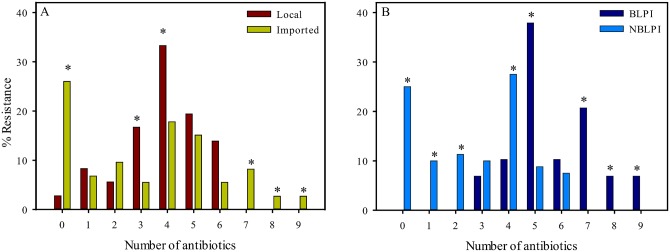
Resistance profile of E. coli meat isolates relative to the number of antibiotics to which isolates exhibited resistance.A: Red bars: strains isolated from local chickens (n = 36); Green bars: strains isolated from imported chickens (n = 73). B: Dark blue bars: Beta-lactamase producing isolates (n = 29). Blue bars: Non beta-lactamase producing isolates (n = 80). * indicates statistical significance (p < 0.05).